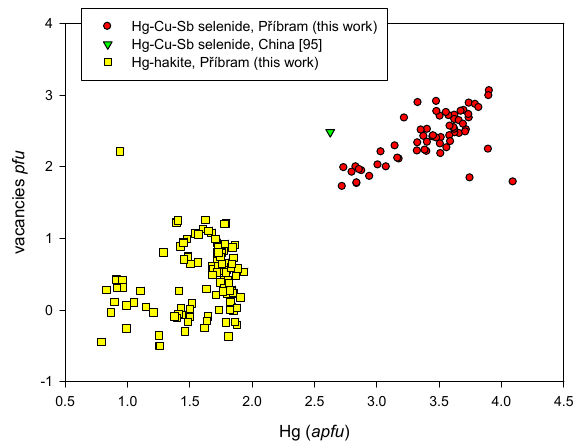
Figure 66. Hg vs. Cu ( apfu ) graph for unnamed Hg-Cu-Sb selenide and Hg-hakite.